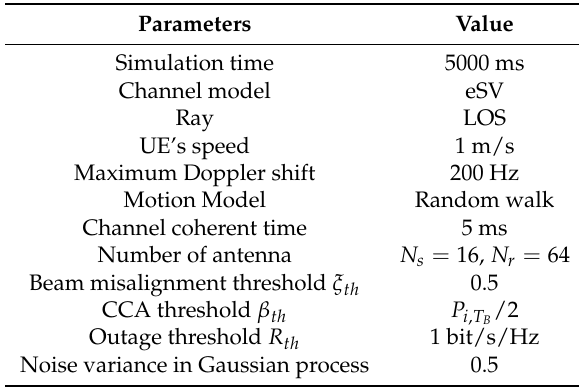
Table 3. Simulation